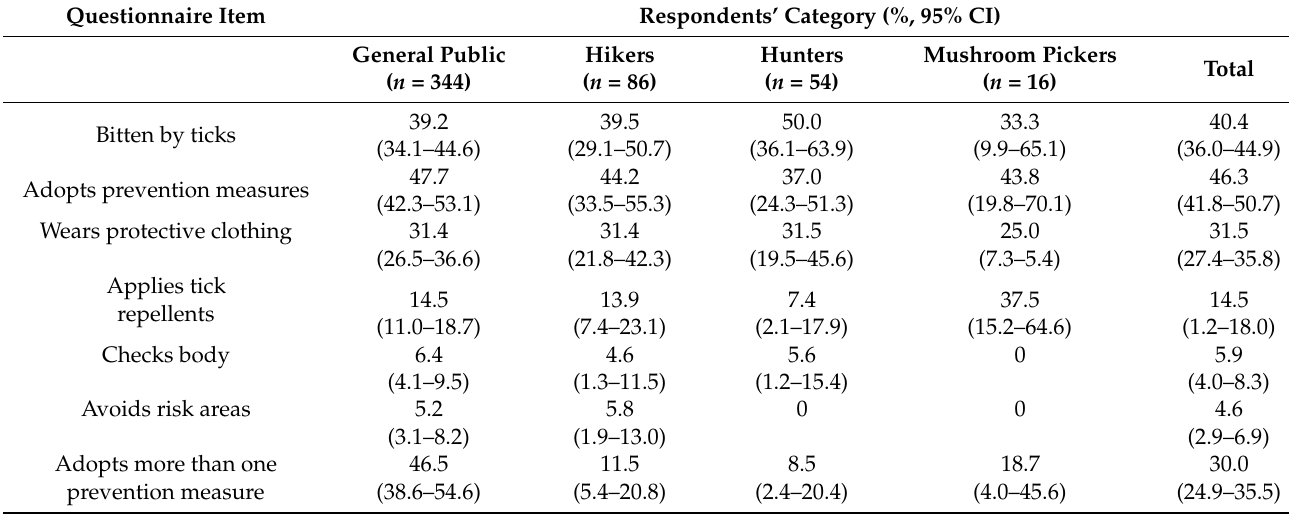
Table 2. Percentage of respondents to the questionnaire reporting tick bites and the adoption of protective measures against ticks, by category of respondents; Turin province,